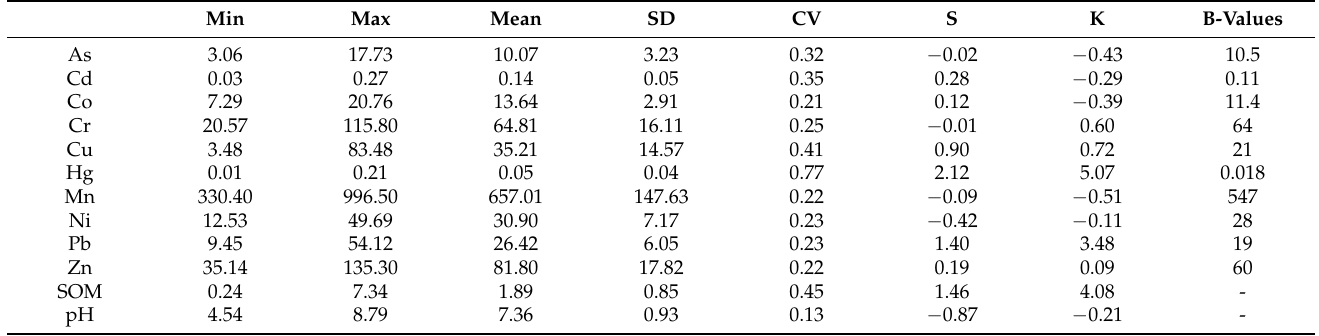
Table 2. Descriptive statistics of heavy metal concentrations, pH and SOM in farmland soil samples ( n =